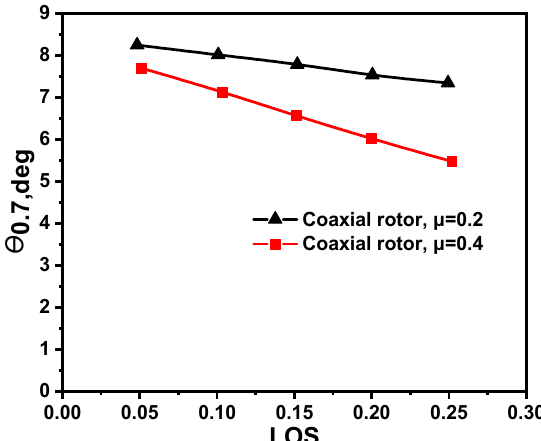
Figure 15. Coupled collective pitch ( θ (cid:2868).(cid:2875) ) as a function of the lift offset (LOS).